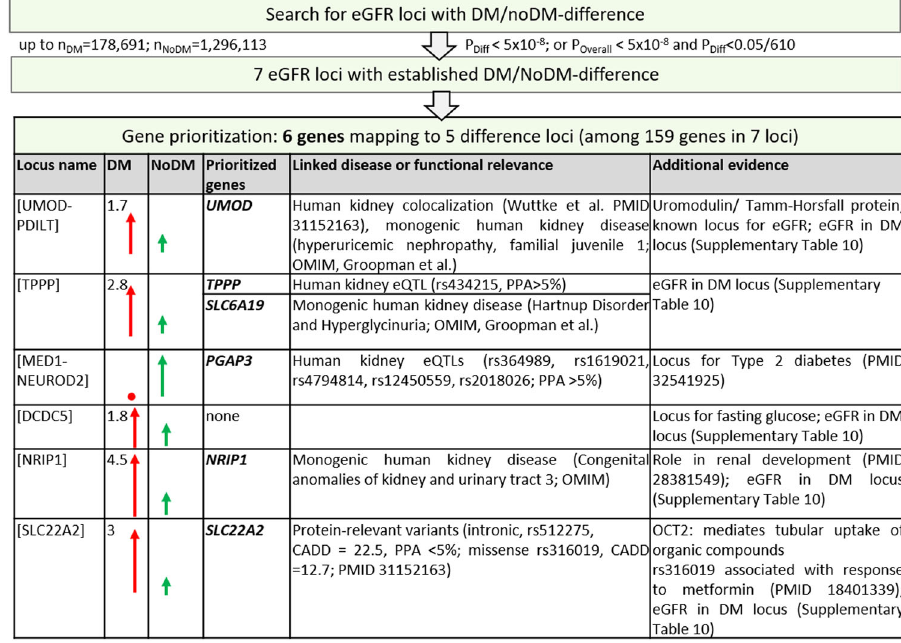
Fig. 6 Gene prioritization highlights six genes at loci with established DM/noDM-difference. Shown are gene prioritization results for the seven loci with established difference (Table 1, Supplementary Fig. 8). We highlighted six genes based on association-driving variants (PPA > 5%) that were deleteriously protein-relevant or expression-modulating, genes that were known as human kidney monogenes (OMIM or ref. 78 with subsequent manual curation) and in addition SLC22A2 due to its known link to metformin at the 7 difference loci: here, we prioritized a gene when it Table 3, Supplementary Fig. 9): (i) among the 40 genes in the four mapped to an association-driving variant (i.e., 99% credible set novel loci with suggestive DM/noDM-difference, 2 genes were variant with posterior probability of association ≥ 5%, Methods) human kidney disease monogenes ( HPS1 and HPSE2 , Fig. 7a); (ii) that was relevant (i) for the protein (with high predicted for the 341 genes in the other 28 novel eGFR loci (i.e., noDM/ deleteriousness 45 , i.e., CADD score ≥ 15) or (ii) for expression in noDM-difference), 10 genes were prioritized (Fig. 7b): 6 genes contained an association-driving variant that was protein- kidney tissue (eQTL, false-discovery rate ≥ 5%) 46,47 or (iii) when deleterious ( AUTS2, CUBN, DVL2, RASSF6, SLC2A4, and the gene was a known kidney disease monogene in human ZFP36L1 ), one gene mapped to an eQTL in glomerular tissue (Methods). We found 6 prioritized genes (Fig. 6, Supplementary ( TNIK ), and 3 additional genes were human kidney disease Fig. 8): (i) PGAP3 mapping to the locus with noDM-only effect monogenes ( SLC2A2, SLC30A9, and SLC7A7 ). Particularly on eGFR (near MED1/NEUROD2 ) and (ii) fi ve genes in loci with more pronounced eGFR-effects in DM but direction-consistent effects in noDM ( TPPP , UMOD, SLC6A19, NRIP1, and SLC22A2 ).